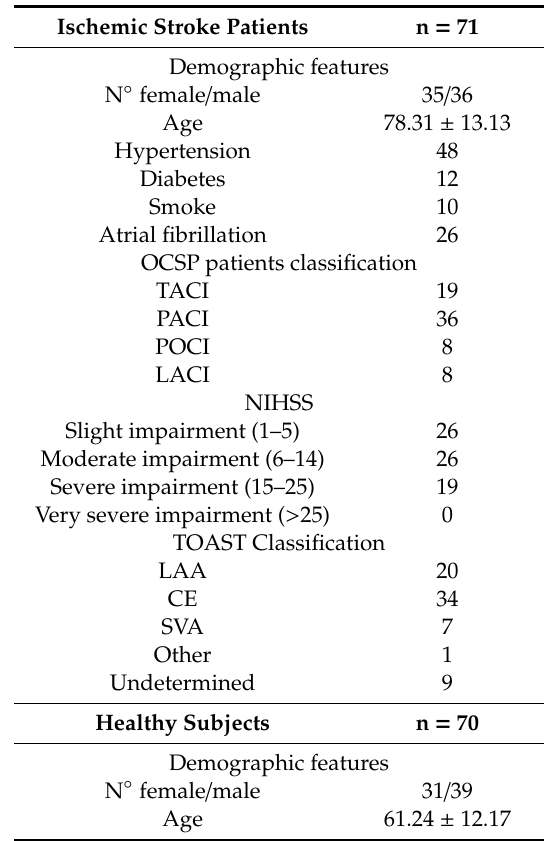
Table 1. Demographic and clinical features of ischemic stroke patients and healthy subjects enrolled in the